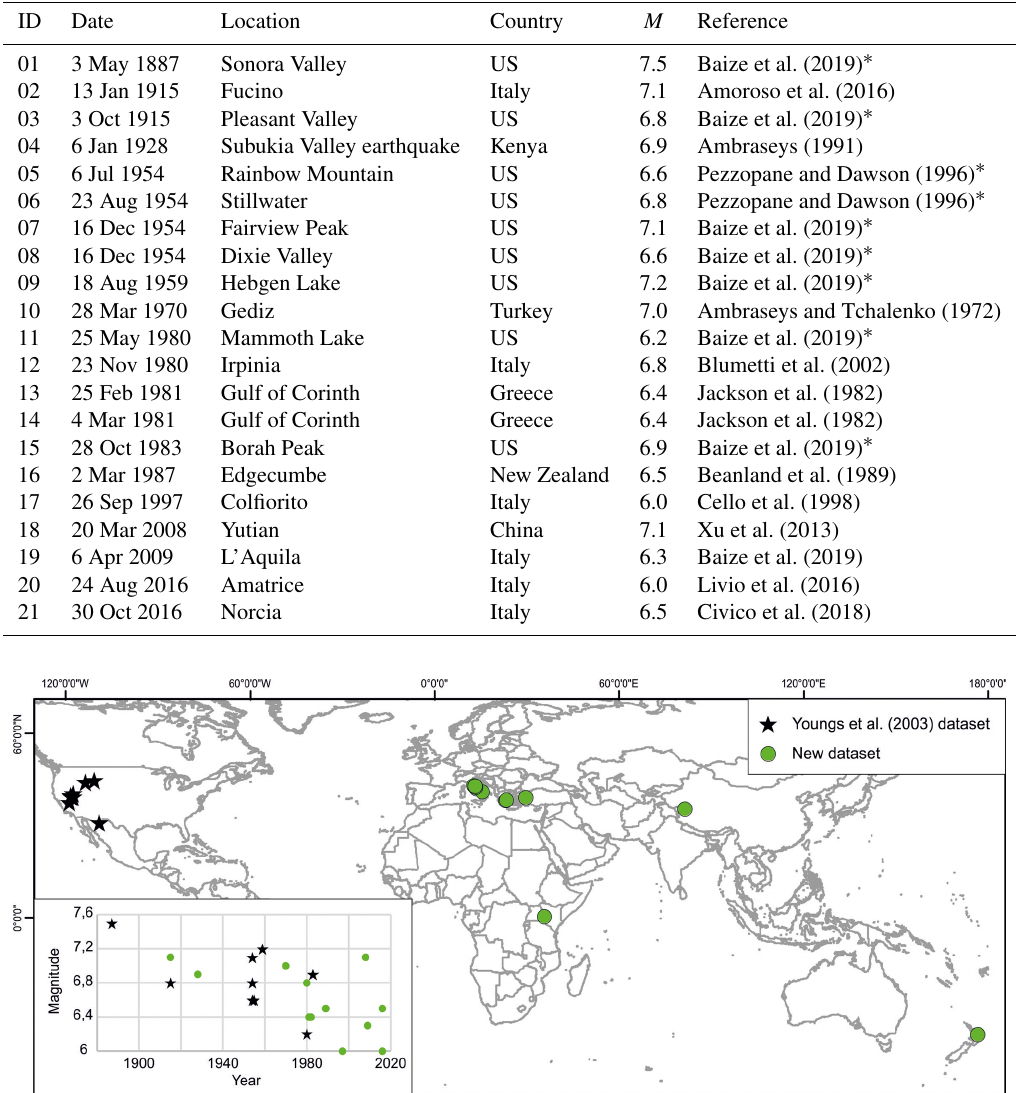
Figure 1. Location of the analyzed events. The inset shows the distribution of the events according to magnitude and time of